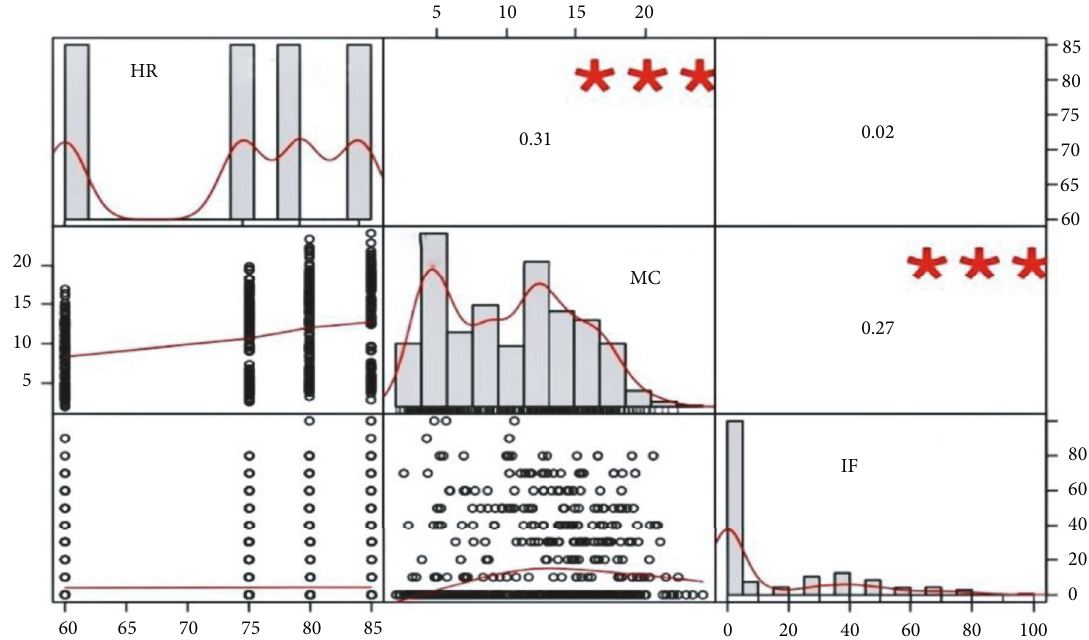
Figure 4: RH, MC, and FI correlation matrix. Pearson’s correlation coefficient and the significant level indicated by an asterisk are shown in the upper triangular matrix. Significant levels are represented by ∗∗∗ Histograms and scatterplots for RH, MC, and FI are shown in the lower diagonal and triangular matrix,